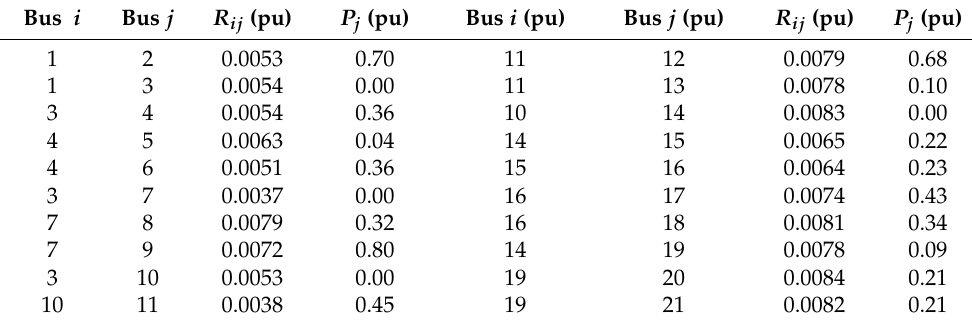
Figure 3. Grid configuration of the 21-bus test system. Table 1. Branch and load information of the 21-bus test